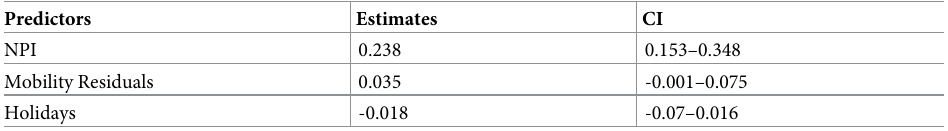
Table 1. Regression coefficients for the multilevel model. Regression coefficients for the multilevel model trained between 12th March and 12th May, 2020. Table shows coefficients, 95% bootstrap confidence intervals, and p values for each predictor.